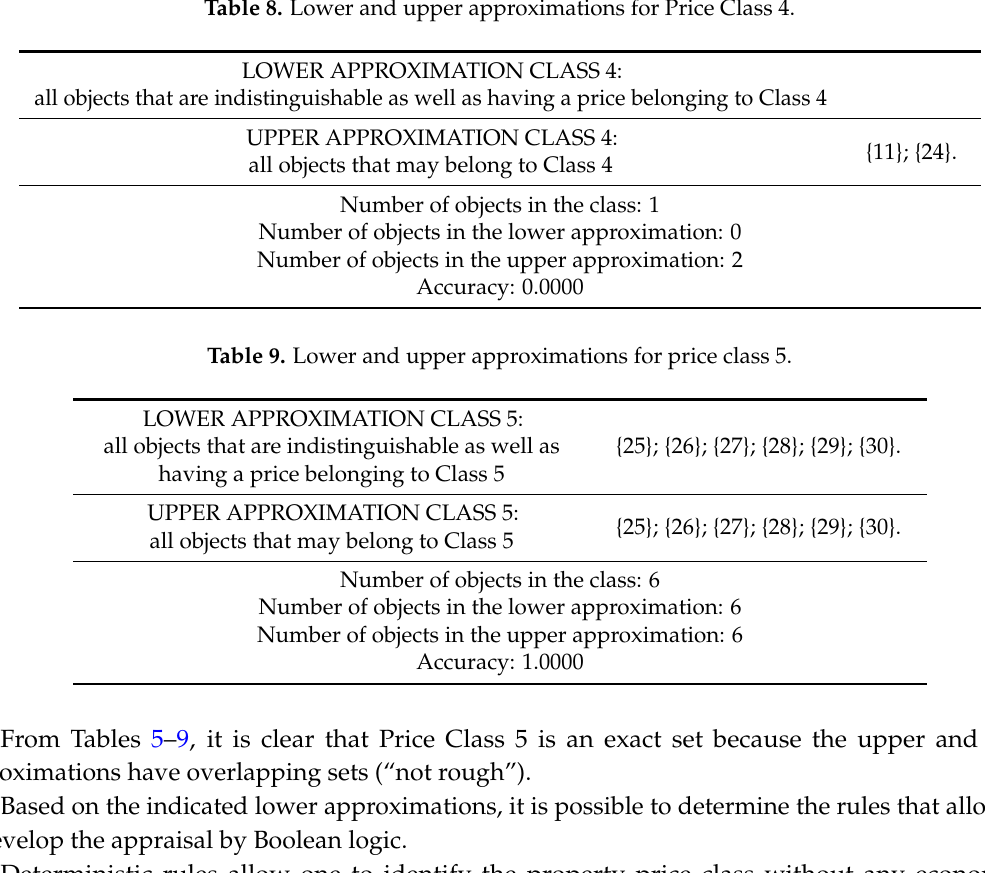
Table 8. Lower and upper approximations for Price Class 4.